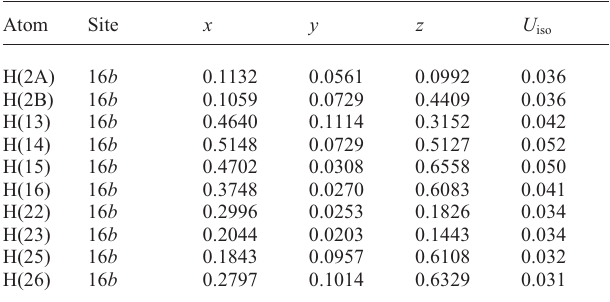
Table 2. Atomic coordinates and displacement parameters (in Å 2 )